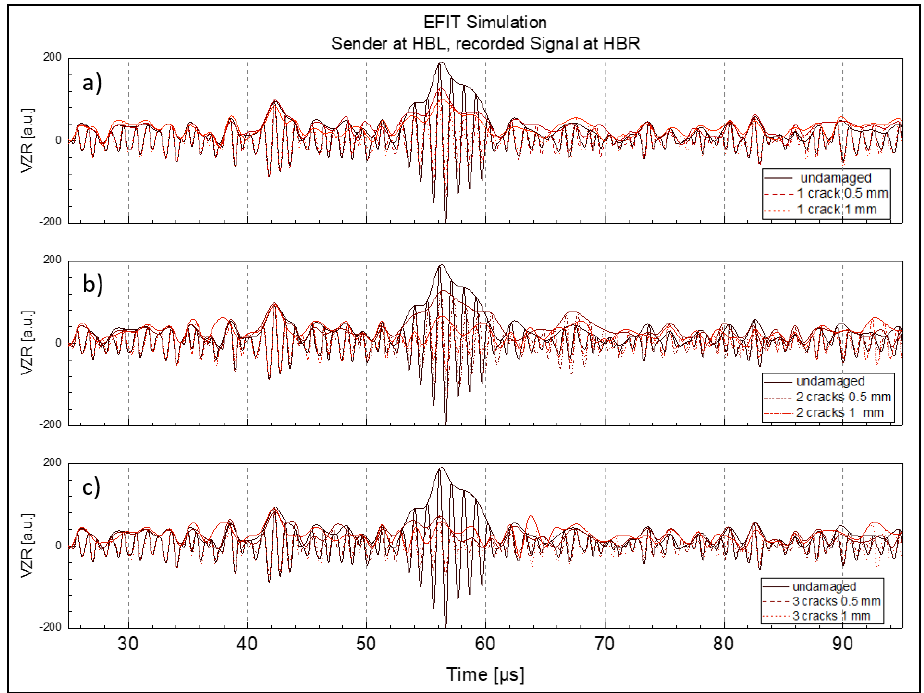
Figure 12. Change of transmitted R-wave received at position HBR with increasing number of cracks and crack depths up to 1 mm; ( a ) 1 crack ( b ) 2 cracks ( c ) 3 cracks.